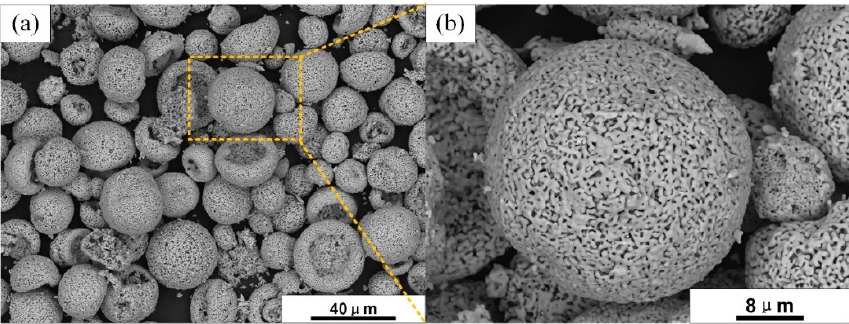
Figure 1. Images of ytterbium silicate feedstock powders at ( a ) low magnification; ( b ) high Figure1. Imagesofytterbiumsilicatefeedstockpowdersat( a )lowmagnification; ( b magnification. Table 3. Two different sets of spray process parameters.